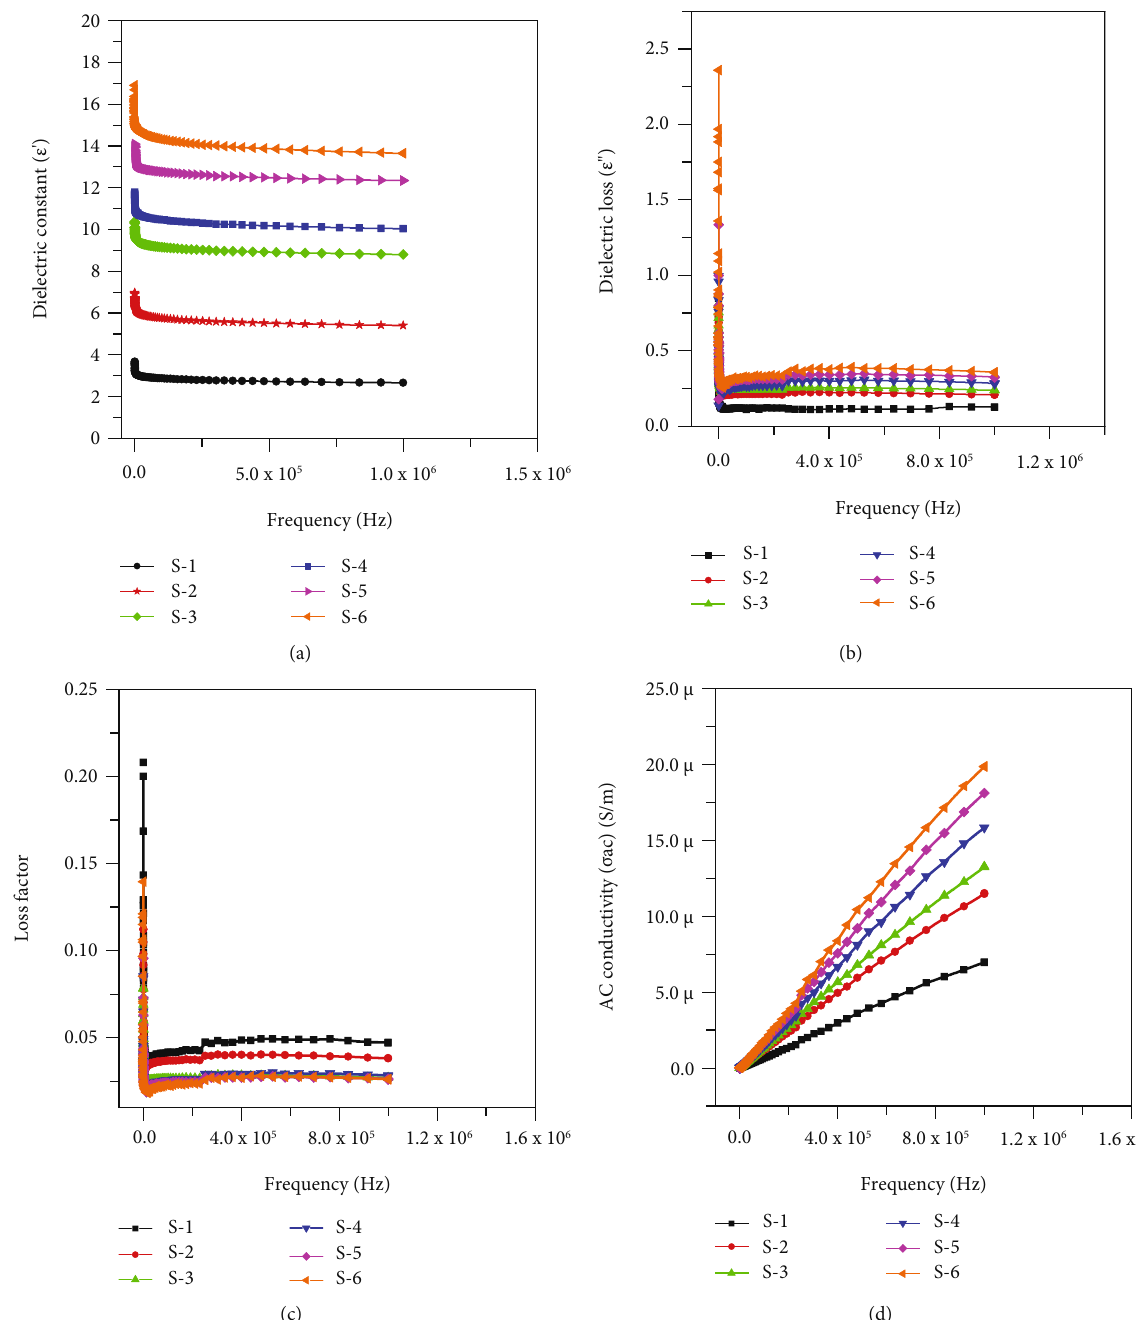
Figure 8: Variation in the values of (a) ɛ ′ , (b) ɛ ″ , (c) tan δ , and (d) σ of silica NFs,